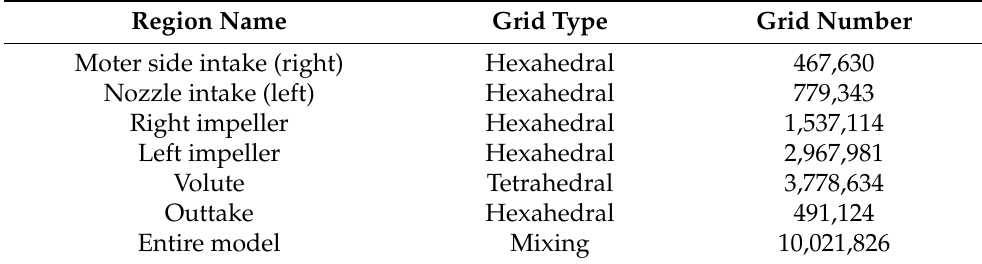
Figure 8. Grid independence verification. Table 2. Grid